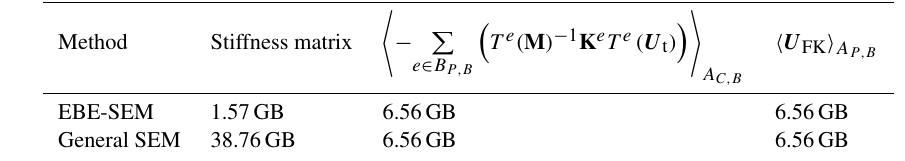
Table 1. Memory requirements of EBE-SEM and the conventional SEM for teleseismic wave modeling. All the values are stored in memory with single float precision. GB denotes gigabyte.